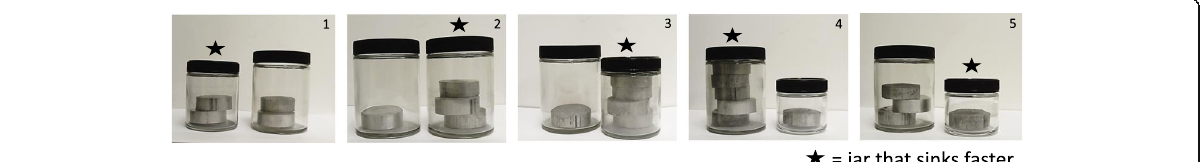
Fig. 1 Examples of pairs of objects used for the predictions. Trials differ in whether the faster object in a pair was small ( 1 ), heavy ( 2 ), small and heavy ( 3 ), big and heavy ( 4 ), or small and light ( 5 )